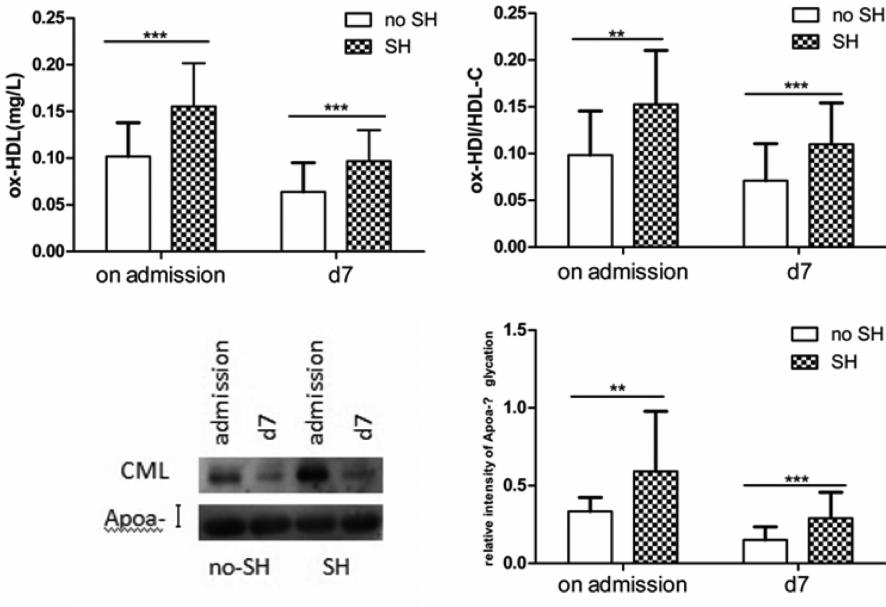
Figure 2. Plasma ox-HDL, ox-HDL/HDL-C, gly-ApoA-I, and relative intensity of ApoA-I glycation in the no SH group and SH group. Plasma ox-HDL, ox-HDL/HDL-C, gly-ApoA-I and relative intensity of ApoA-I glycation were quantified in the two groups (no SH group and SH group) on admission and d7. CML: gly-ApoA-I. (cid:1) p < (cid:1)(cid:1) p < (cid:1)(cid:1)(cid:1) p < # p > 0.05, 0.05, 0.01, and 0.001. Data are presented as mean±SD.